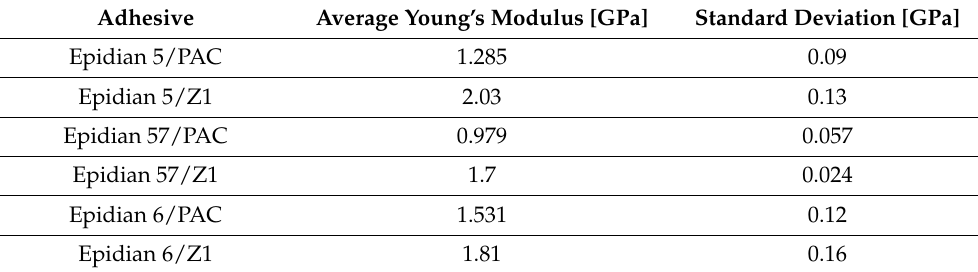
Table 2. Average Young’s modulus values determined in a tensile test of the adhesive material.